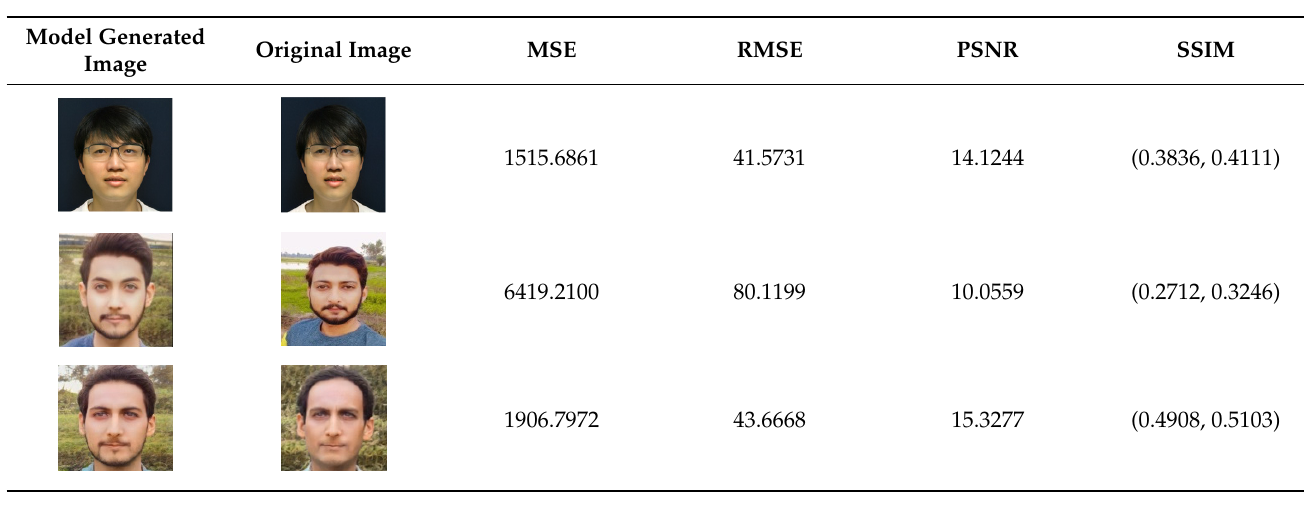
Table 2. MSE, RMSE, PSNR, and SSIM evaluation on sample images. Model Generated Original Image